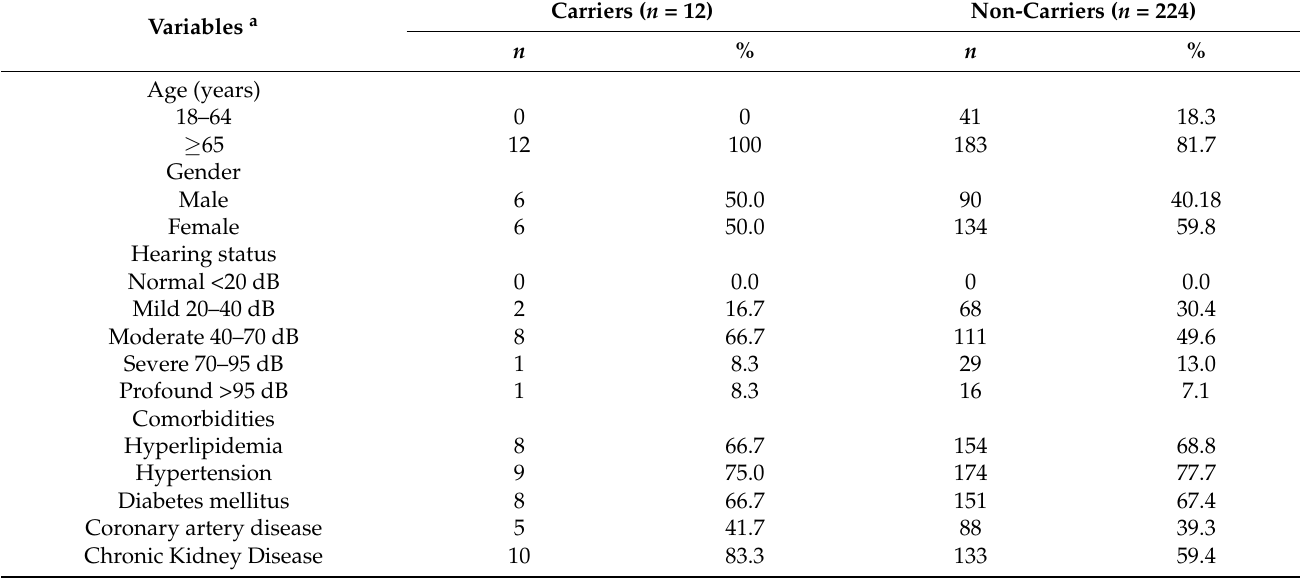
Table 3. Characteristics of KCNQ4 c.546C>G carriers and